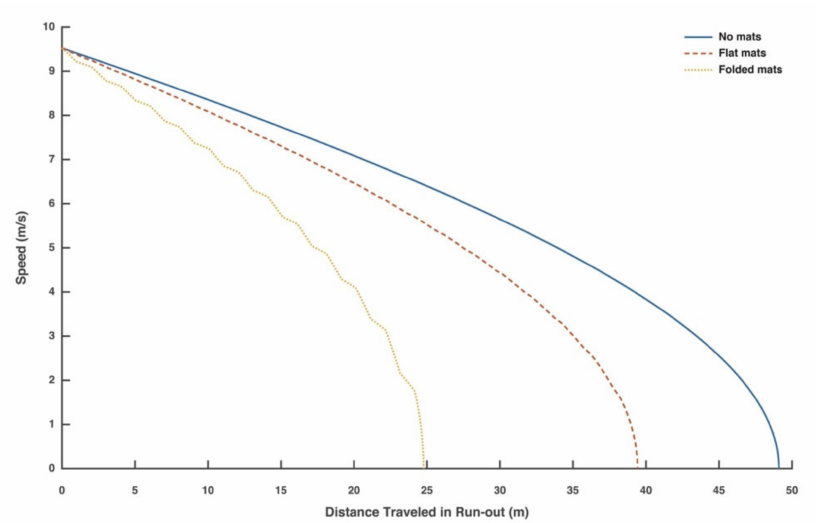
Figure 4. Example of the distance traveled by a snow tube system in a horizontal run-out when using no mats, flat deceleration mats, or folded deceleration